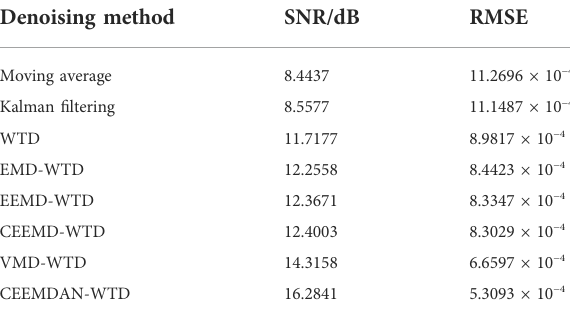
TABLE 3 SNR and RMSE results after denoising the DAS